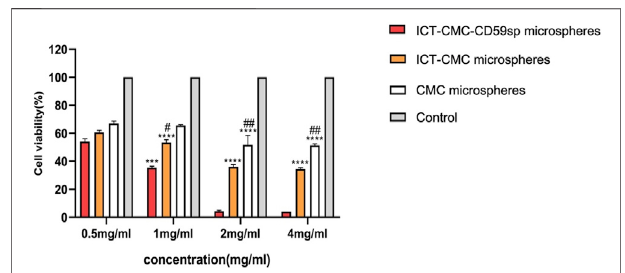
FIGURE 7 | Killing effect of microspheres on OSCC-9 cells (ICT-CMC- CD59sp group compared with other groups, *** p < 0.001; CMC group compared with ICT-CM group, # p < 0.05, ## p < 0.01).